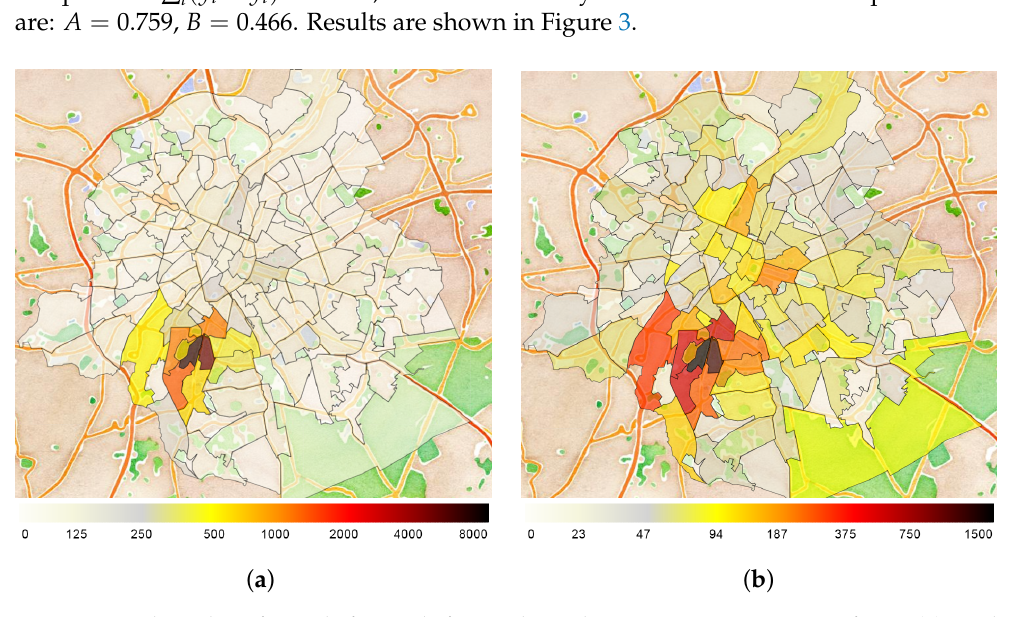
Figure 3. Total number of trips, before and after applying the Driving Ratio correction factor. ( a ) Total number of trips (regular and irregular) originating from Altitude 100 before applying the DR correction factor. ( b ) Total number of trips (regular and irregular) originating from Altitude 100 after applying the DR correction